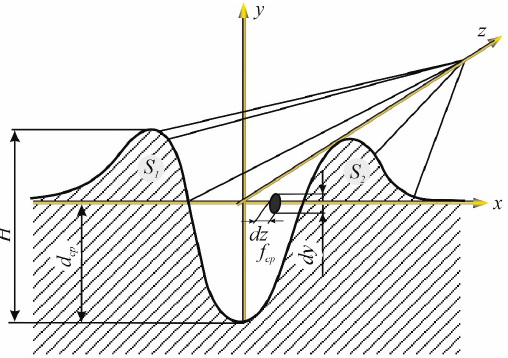
Figure 1. Diagram of a single mark applied by a diamond cone to the polished surface of a steel sample.